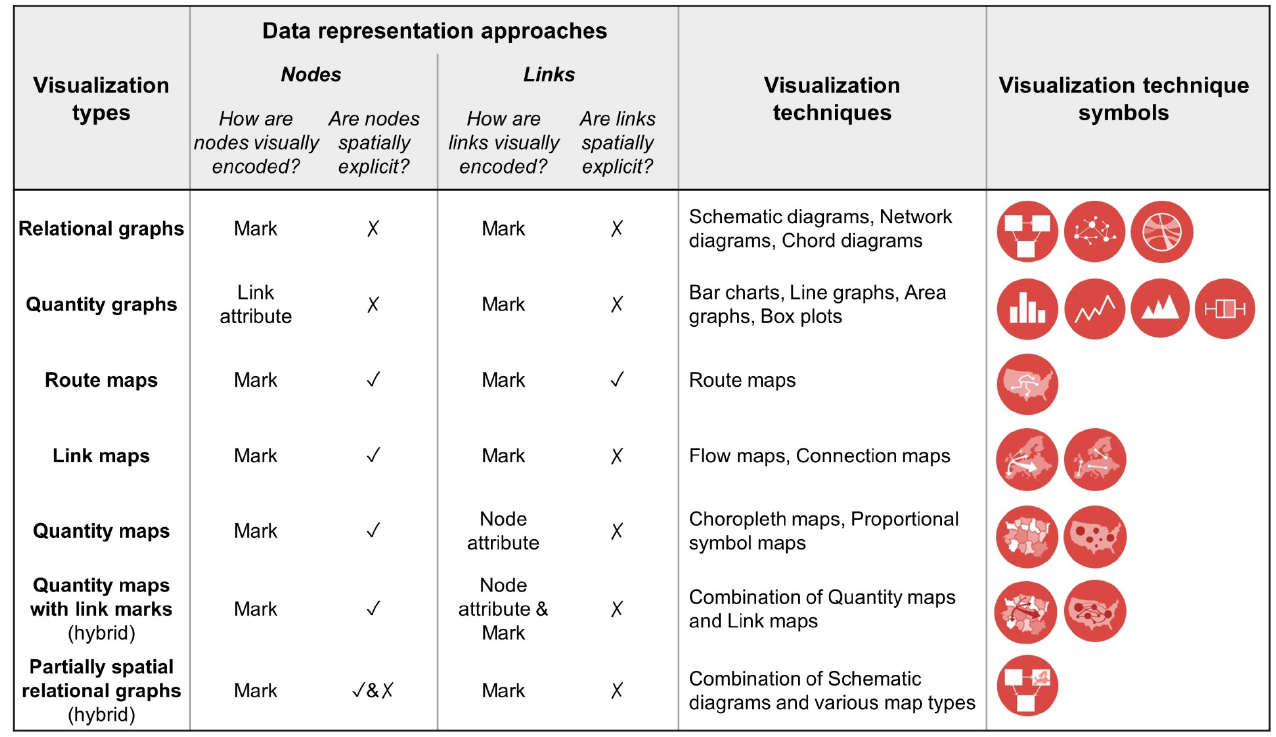
Fig. 7 . Overview of visualization types used to display telecoupling dynamics, approaches used to represent node and link data, and their association with different visualization techniques (the order of the naming of the techniques corresponds to the order of the listed